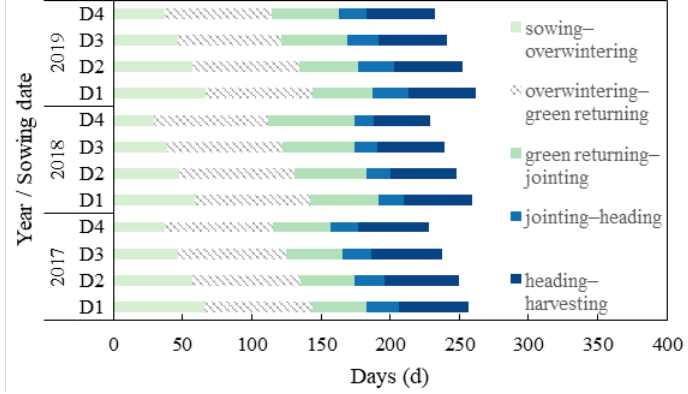
Figure 2. Variation in the length of different developmental stages of winter wheat for different sowing dates.